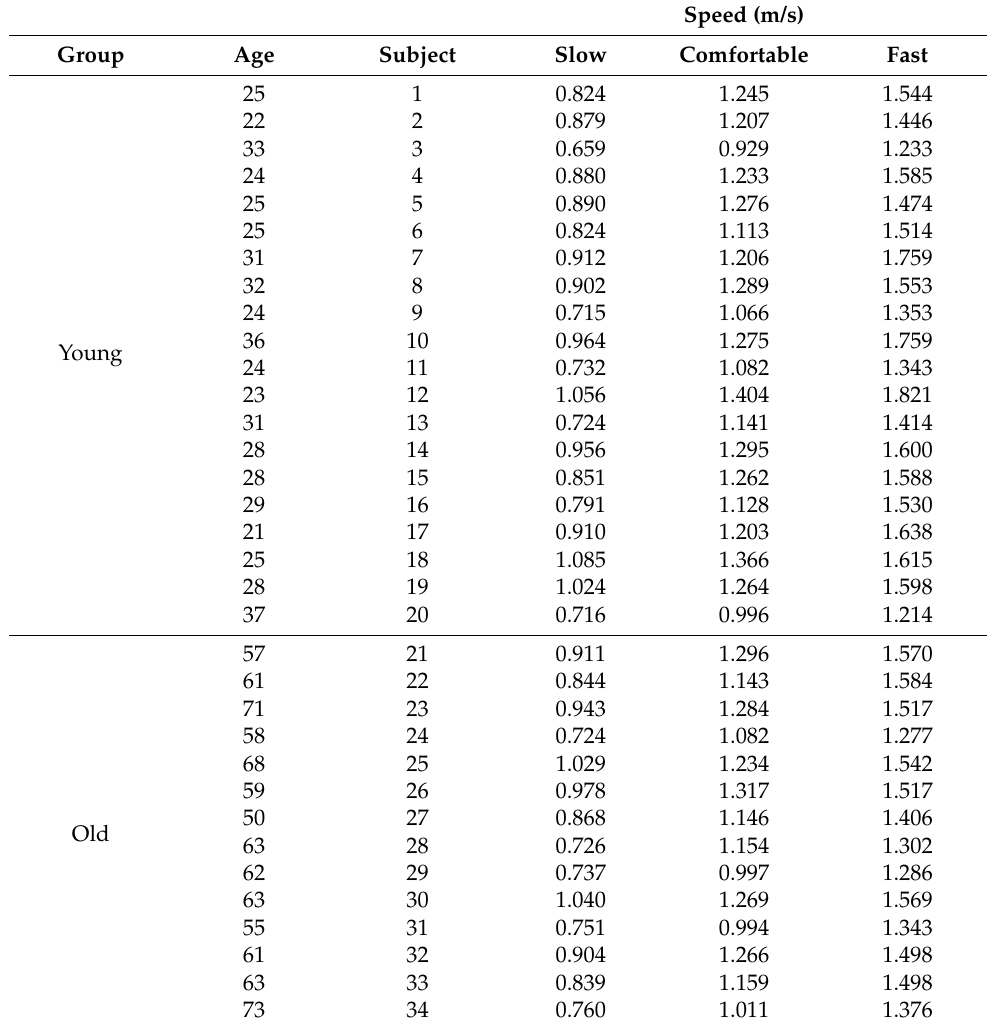
Table 2. Age and average speed of each subject at different speed level (Slow, Comfortable, and Fast) calculated from [33]. For each speed level, the average speed is calculated across all trials of each